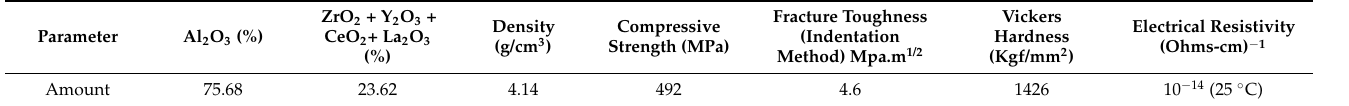
Table 3. Specifications of Excetek ed 400 Die ‐ Sinker electro discharge machining (EDM).